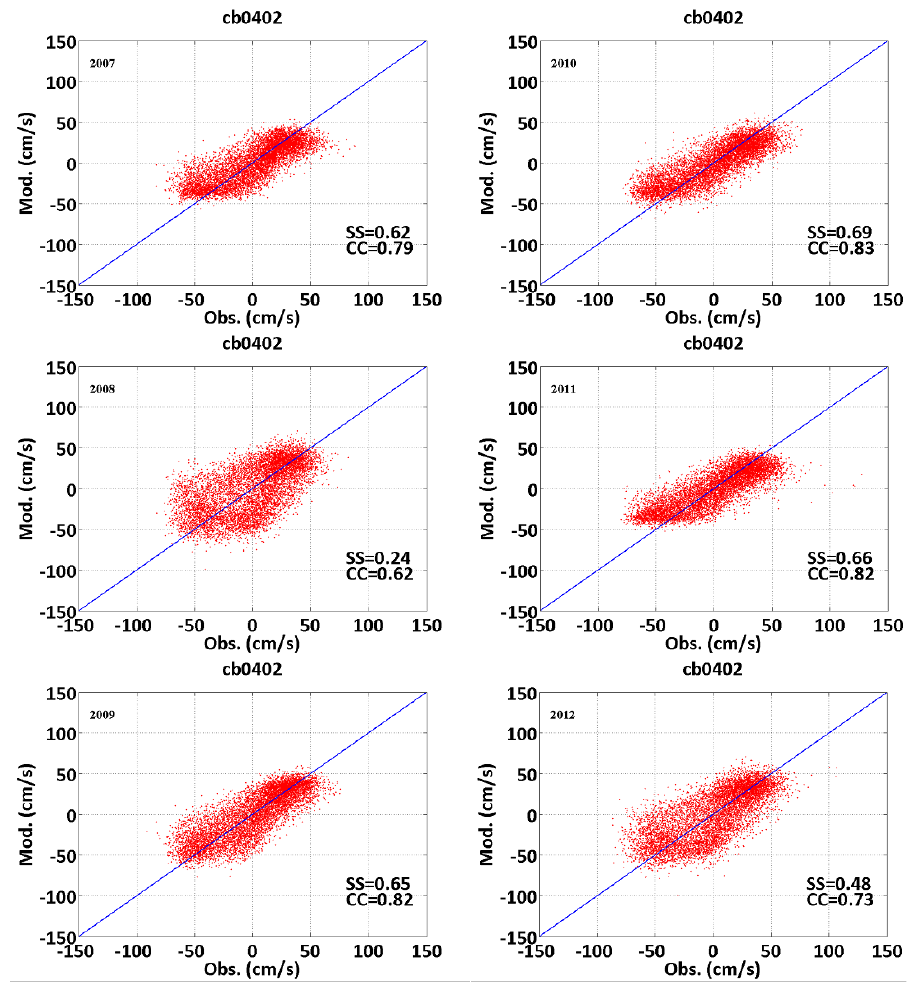
Figure 3. Scatter plots of comparisons of modeled versus observed current (SS is the model skill and CC is the correlation coefficient) .